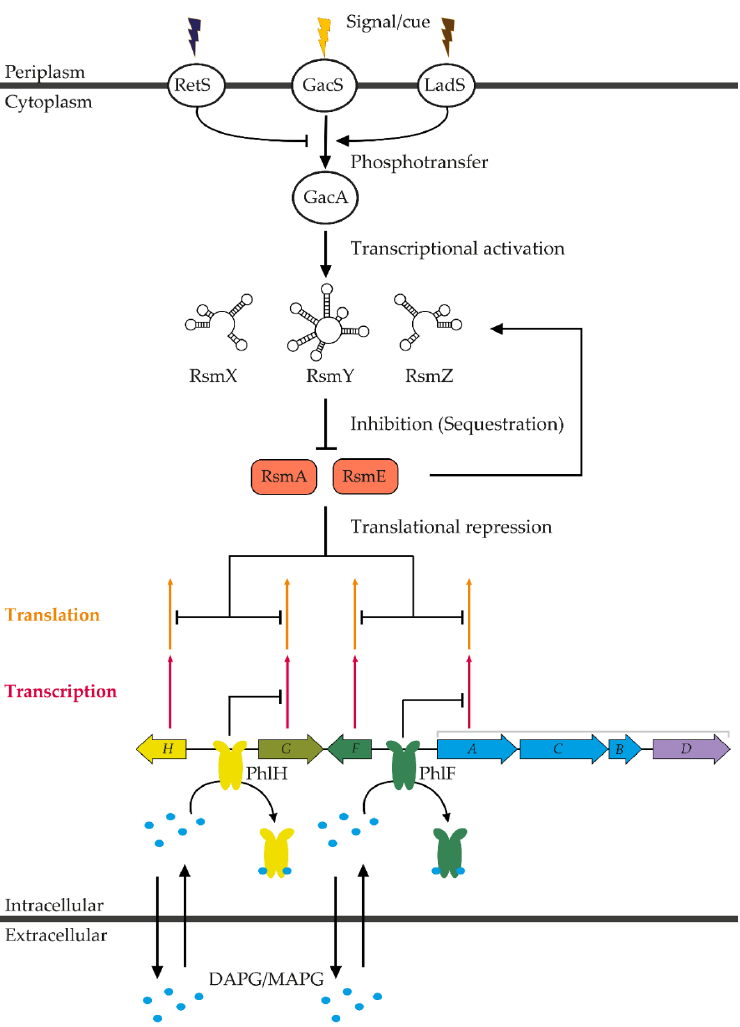
Figure 3. Regulation of DAPG biosynthesis in Pseudomonas spp. DAPG production is regulated at the transcriptional level by the TetR repressors PhlH and PhlF, and at the posttranscriptional level via the Gac/Rsm pathway. PhlF binds as a dimer to the operator phO , located between phlF and phlA and represses the expression of phlABCD . When DAPG and MAPG concentrations increase, MAPG and DAPG interact with PhlF, dissociating the phO -PhlF complex and relieving phlACBD transcription. Likewise, PhlH binds to an operator, located between phlH and phlG and represses phlG expression. DAPG and MAPG can dissociate PhlF-DNA binding and relieve phlG expression. Upon reception of an environmental cue, GacS activate GacA by phosphotransfer. GacA activates the transcription of several small non-coding RNAs (RsmX, RsmY and RsmZ), which in turn se- quester the RNA-binding proteins RsmA/RsmE, relieving phlABCD expression. The phlF and phlH genes encode two pathway-specific regulators from the TetR fam- ily. The TetR family regulators consist of an N-terminal DNA-binding domain and a C- terminal domain [44]. These regulators bind to palindromic repeated sequences localized upstream of the target gene, repressing its expression. In most cases, the C-terminal do- main interacts with one or several ligands, which subsequently reduce the ability of the